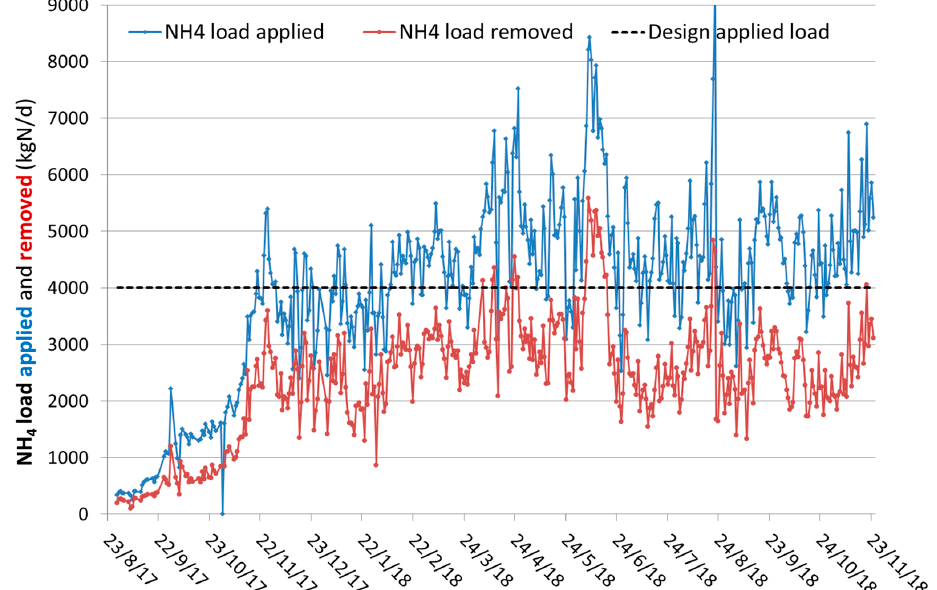
Figure 5. Photo of the ANITA Mox reactor in Denver retrofitted into an existing RAS reaeration tank.